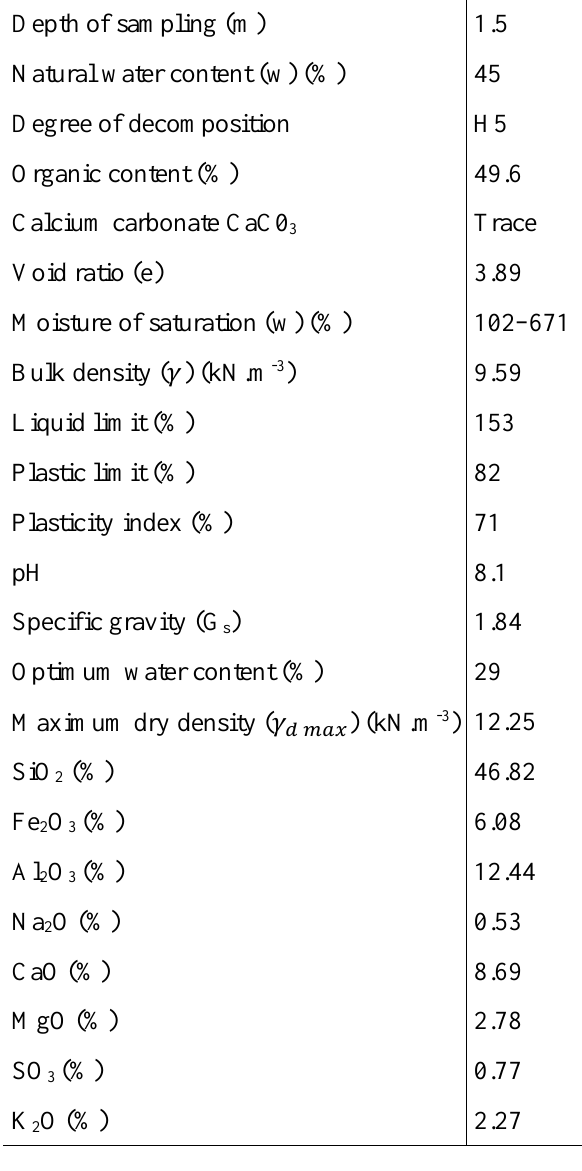
Table 1. Physical and chemical properties of Urmia Lake peat.